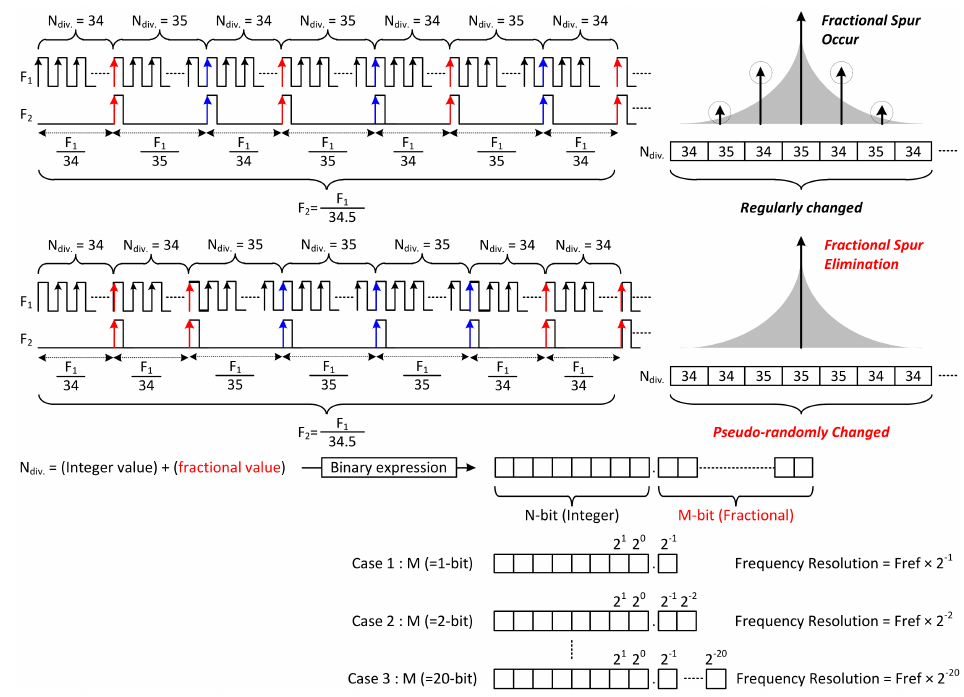
Figure 16. The operating principle and role of the SDM.